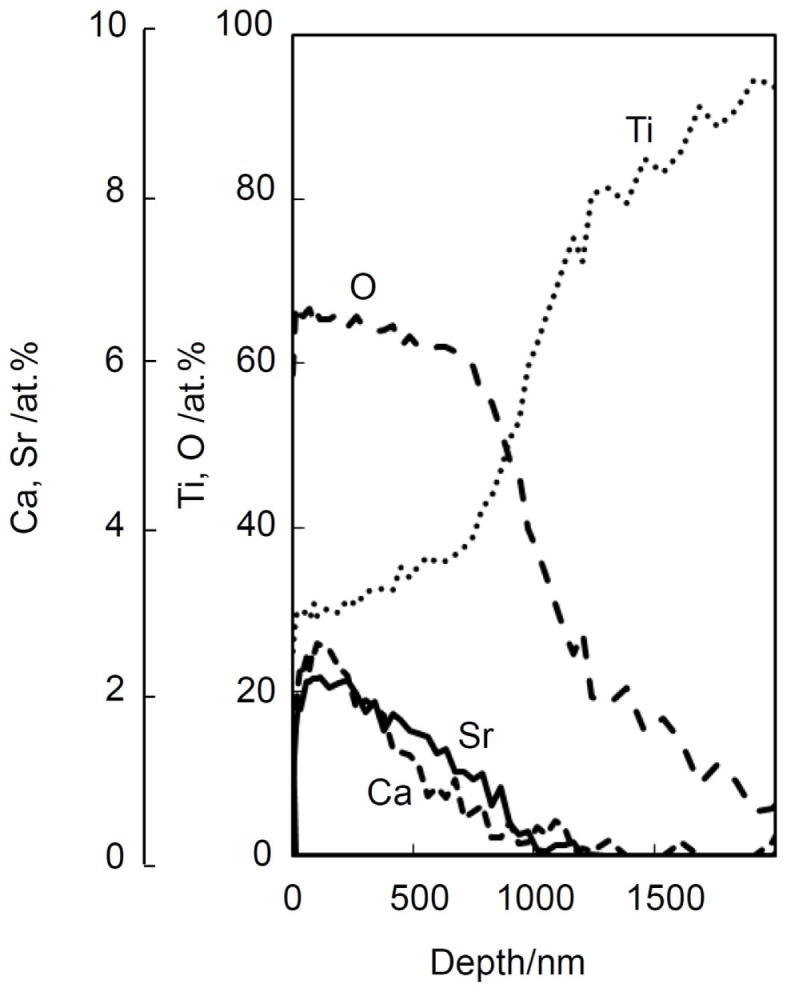
Depth profile of XPS of Ti metal subjected to NaOH, CaCl2/SrCl2, heat, and SrCl2 treatments. Reproduced from Yamaguchi et al. (2014) with permission Elsevier.